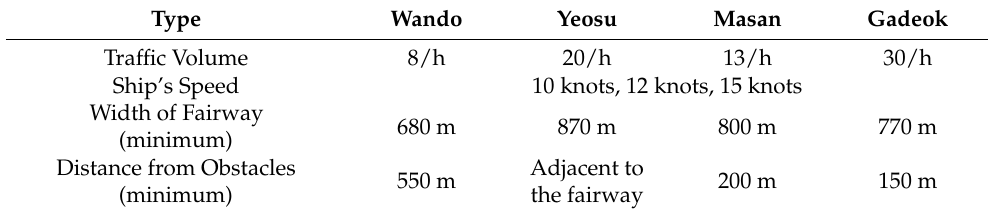
Table 7. Details of collision and grounding risk assessment